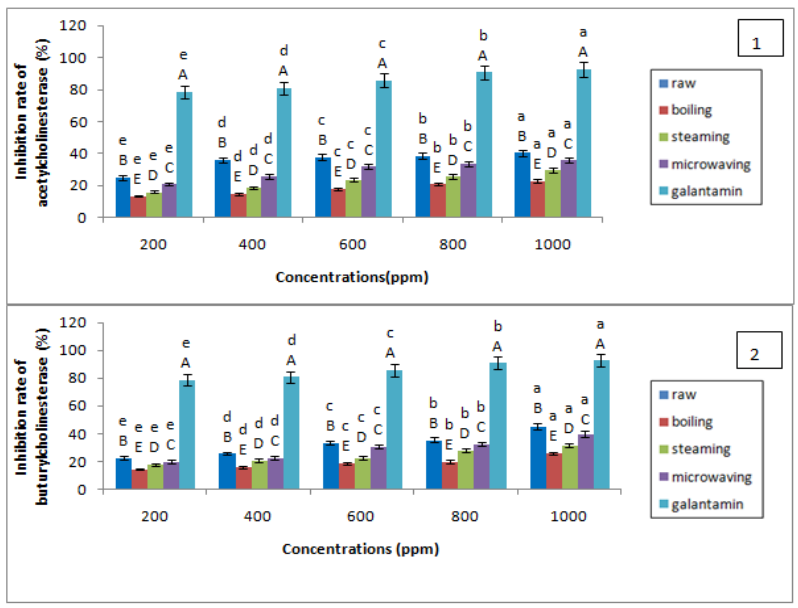
Figure 15. Evaluation of anticholinesterase activity of raw and cooked potato extracts: 1: antiacetylcholinesterase activity; and 2: antibutyrylcholinesterase activity. The superscript letters A, B, C, D, and E indicate a significant difference between anticholinesterase activities of raw and cooked potatoes at the same concentration of extract (ppm) (at the 0.05 significance level. The superscript letters a, b, c, d, and e indicate a significant difference between anticholinesterase activities of raw and cooked potatoes at different concentrations of extract (ppm) at the 0.05 significance level. Potato extracts showed low inhibitory activity of acetylcholinesterase (AChE) and butyrylcholinesterase (BChE). A decrease in anticholinesterase activity was obtained after cooking, a significant difference ( p < 0.05) exists between the raw potato and the cooked samples and the different concentrations of the extract.